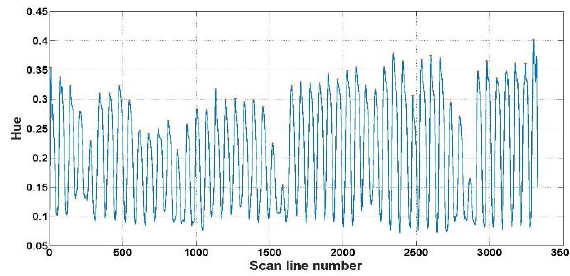
Figure 6. Average Hue value for each scan line.